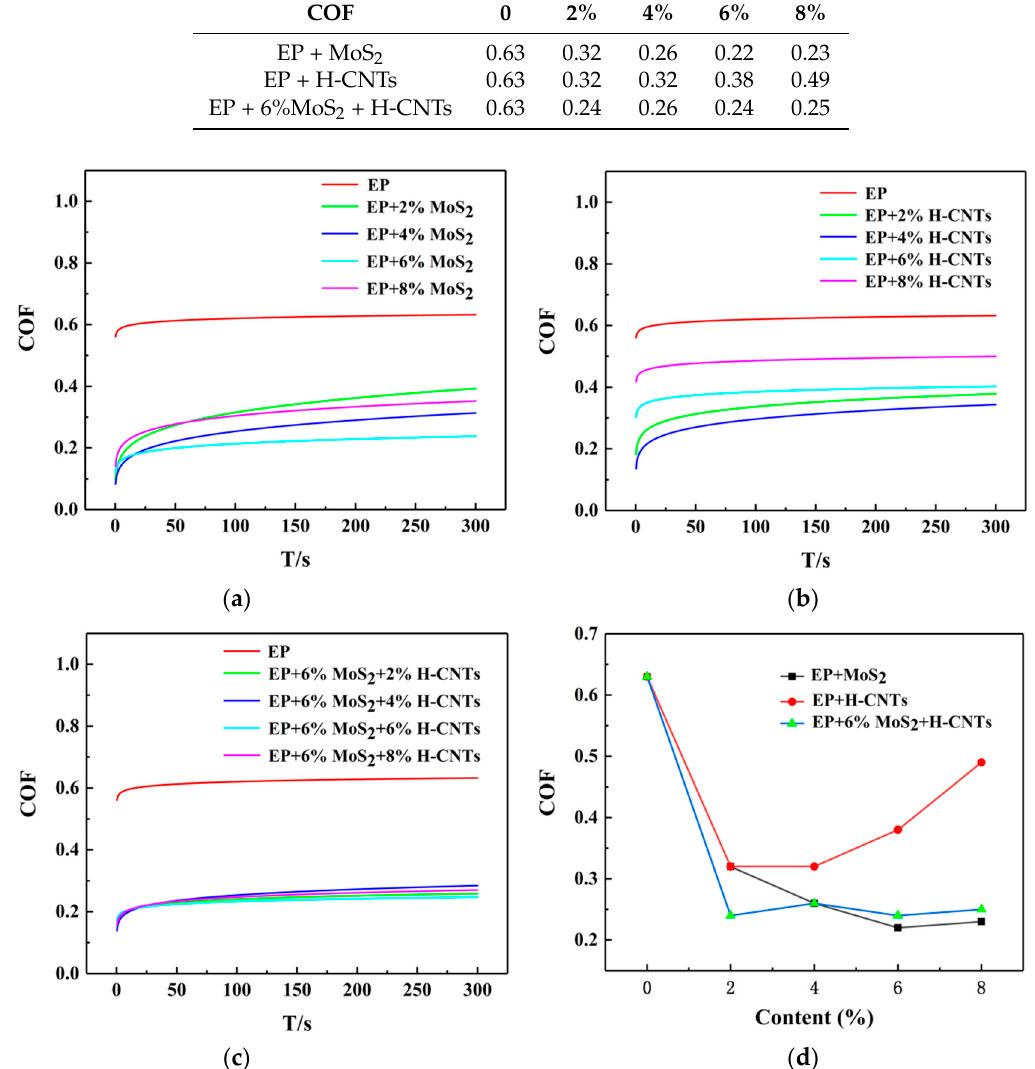
Figure 6. Effect of different contents of additives on the friction coefficient of the composites. ( a ) MoS 2 , ( b ) H-CNTs, ( c ) 6% MoS 2 + H-CNTs, ( d ) comparison of the friction coefficients from three experimental groups. experimental